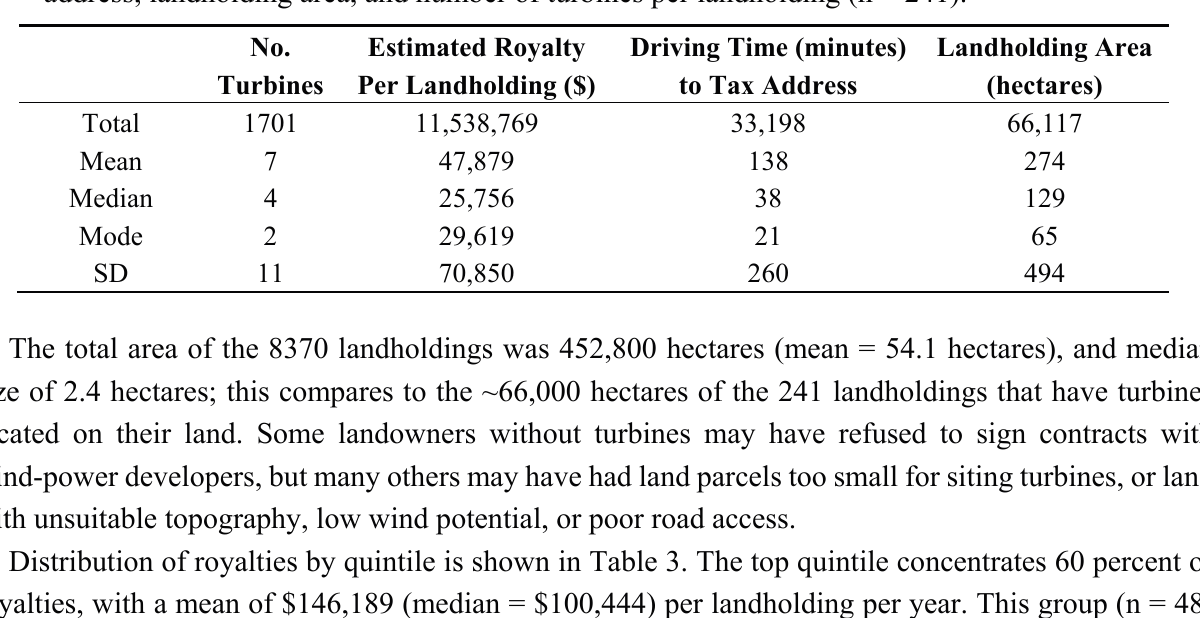
Table 2. Summary statistics for estimated royalty, distance between landholding and tax address, landholding area, and number of turbines per landholding (n =